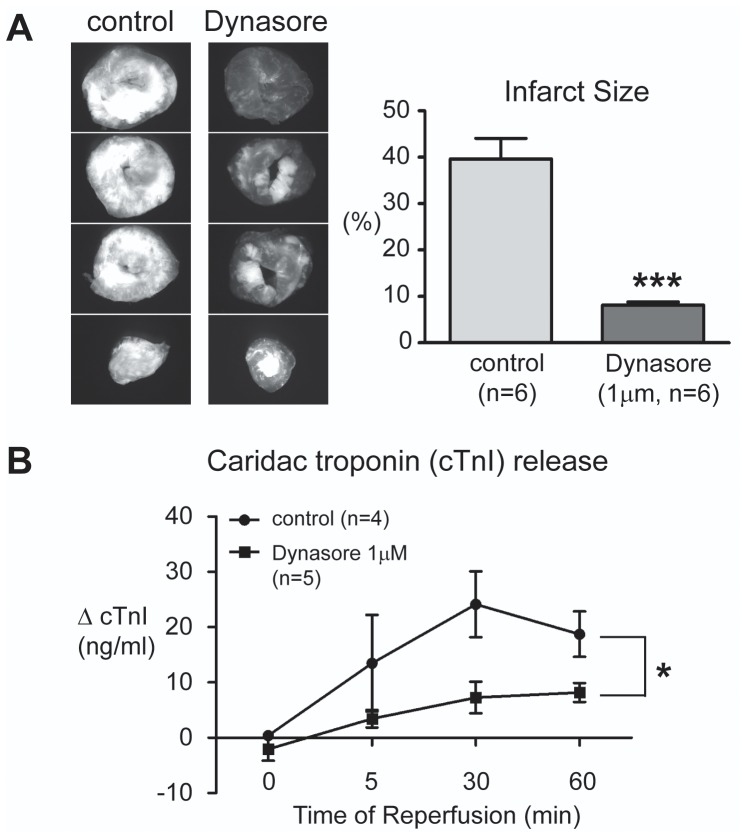
Dynasore decreases cardiomyocyte death in I/R injured mouse hearts.A. Myocardial infarct size was analyzed by Propidium Iodide (PI) perfusion. Left, representative fluorescence images of PI staining in a control and Dynasore treated hearts subjected to I/R injury. Right, average infarct size is presented as percentage over total left ventricular area and compared between the two treatment groups. B. Dynasore decreases cardiac troponin I (cTnI) efflux. Myocardial damage was evaluated by measurement of the release of cTnI in the coronary effluent during the 60 min reperfusion period. (* P<0.05, ***P<0.001).